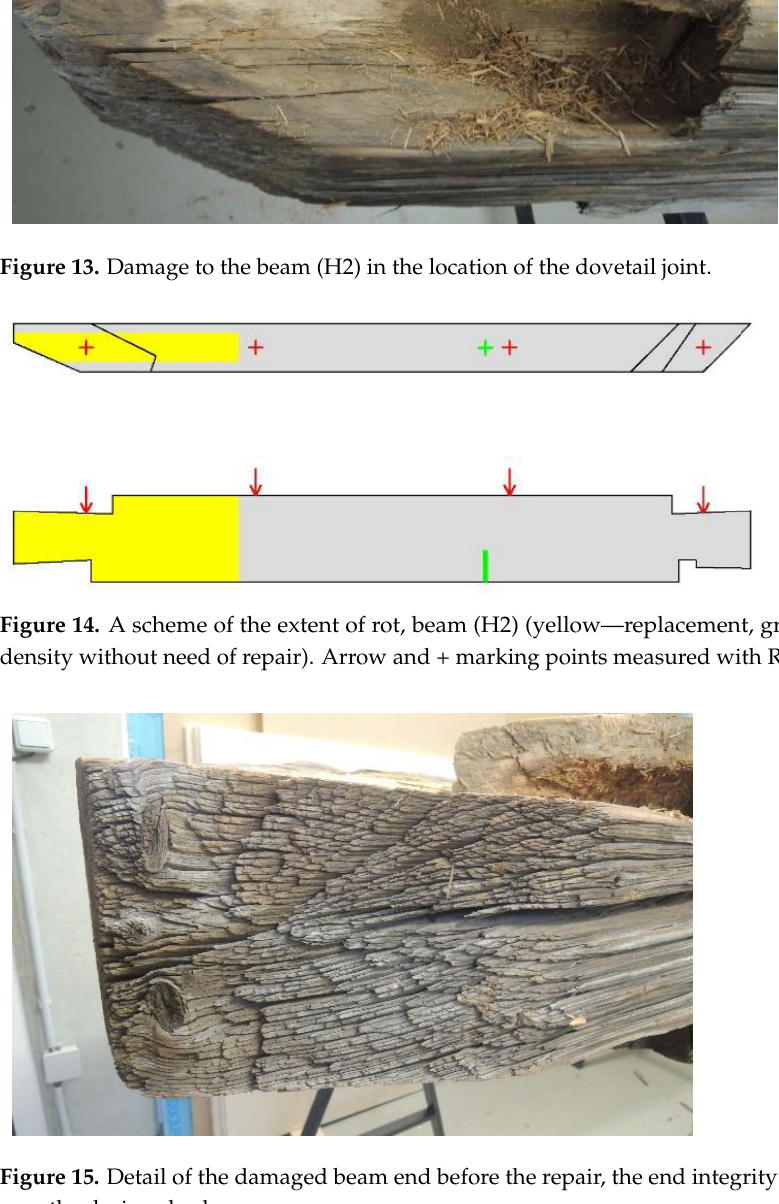
Figure 16. Detail of the cleaned hole in the central part of the beam, including the grooves for the rear insert.